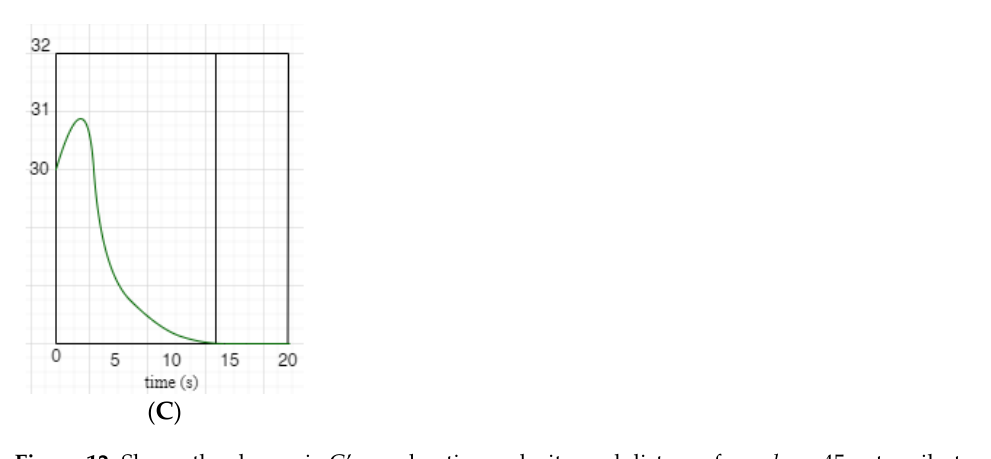
Figure 12. Shows the change in C’s acceleration, velocity, and distance from d ref = 45 m to milestone D = 42 m when the verifier’s speed drops from 30 m/s to 27 m/s. ( A ) Acceleration; ( B ) Velocity; ( C ) Following